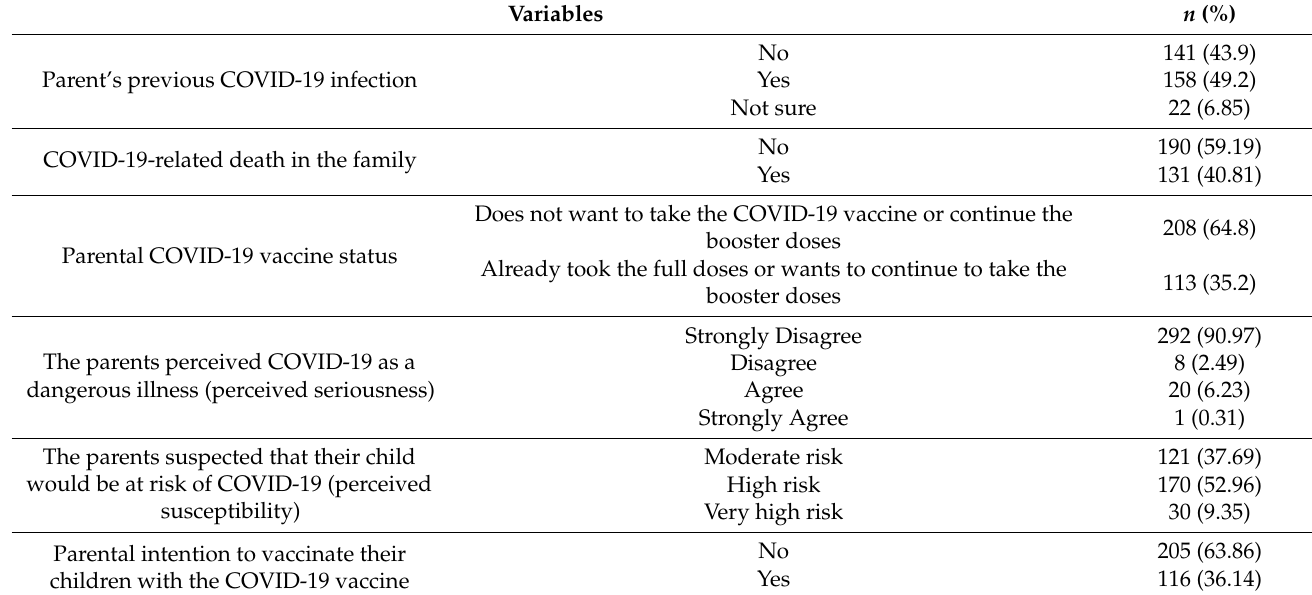
Table 3. Parental beliefs and attitudes towards COVID-19 and vaccination ( n =